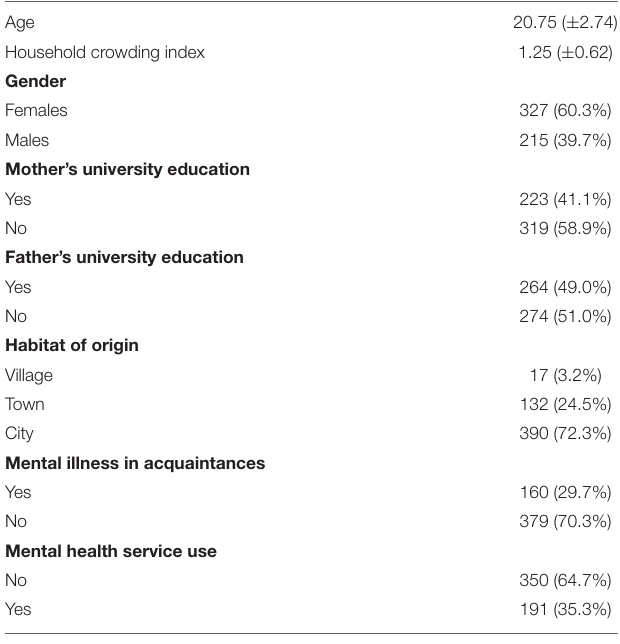
TABLE 1 | Background characteristics and associated frequencies (%); for age and household crowding index the mean ( ± SD) is presented.